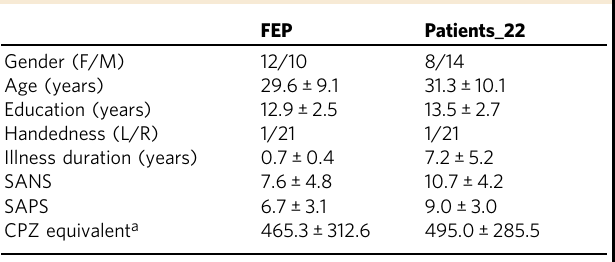
EEG recording and data processing . Participants were sitting in a dim lit room. They were instructed to keep their eyes closed and to relax for 5min. Resting-state EEG was recorded before participants participated in a masking experiment and using a BioSemi Active 2 system (Biosemi) with 64 Ag-AgCl sintered active elec- trodes, referenced to the common mode sense electrode. The recording sampling rate was 2048 Hz. Of fl ine data were downsampled to 128 Hz and preprocessed using an automatic pipeline (APP) 51 : fi ltering with a bandpass of 1 – 40 Hz; removal of powerline noise; re-referencing to the biweight estimate of the mean of all channels; removal and 3D spline interpolation of bad channels; removal of bad EEG periods; independent component analysis to remove eye movement-, mus- cular- and bad channel-related artifacts; re-referencing to common average refer- ence. The proportion of interpolated electrodes was <5% for each participant. The amount of removed EEG periods was 5.56% ±3.78 for patients, 4.65% ±3.42 for siblings and 4.96% ± 3.76 for controls. A one-way ANOVA revealed nonsigni fi cant effect of group on the amount of removed EEG periods ( F (2,216) = 0.810, p = 0.446). For Patients_22 and FEP, the amount of removed EEG periods was 5.03% ± 4.53 and 3.46%± 2.08, for each group, respectively. An independent samples t - test showed that the amount of removed EEG periods was not signi fi cantly dif- ferent between Patients_22 and FEP ( t (42) = 0.145, p = 0.145). The global fi eld power (GFP) of the preprocessed EEG data was determined for each participant. GFP is an instantaneous reference-independent measure of neuronal activity throughout the brain, and it is calculated as the standard deviation of the electrical potential across all electrodes at each time point 52 . Since EEG map topographies remain stable around the GFP peaks and these are the best representatives of the topographic maps regarding signal-to-noise ratio 38 , only EEG topographies at the GFP peaks were submitted to further analysis. The GFP- reduced data were submitted to k-means clustering 12,24 to identify the most dominant topographies as classes of microstates present in the recordings. The clustering analysis was fi rst done at the individual level and then across participants in each group. To have equal contributions of microstates per participant, each participant contributed to the group k-means clustering with his/hers four most dominant microstates. To compare our results with previous studies, we selected Table 5 Group average statistics (±SD) of the FEP and Patients_22 groups.